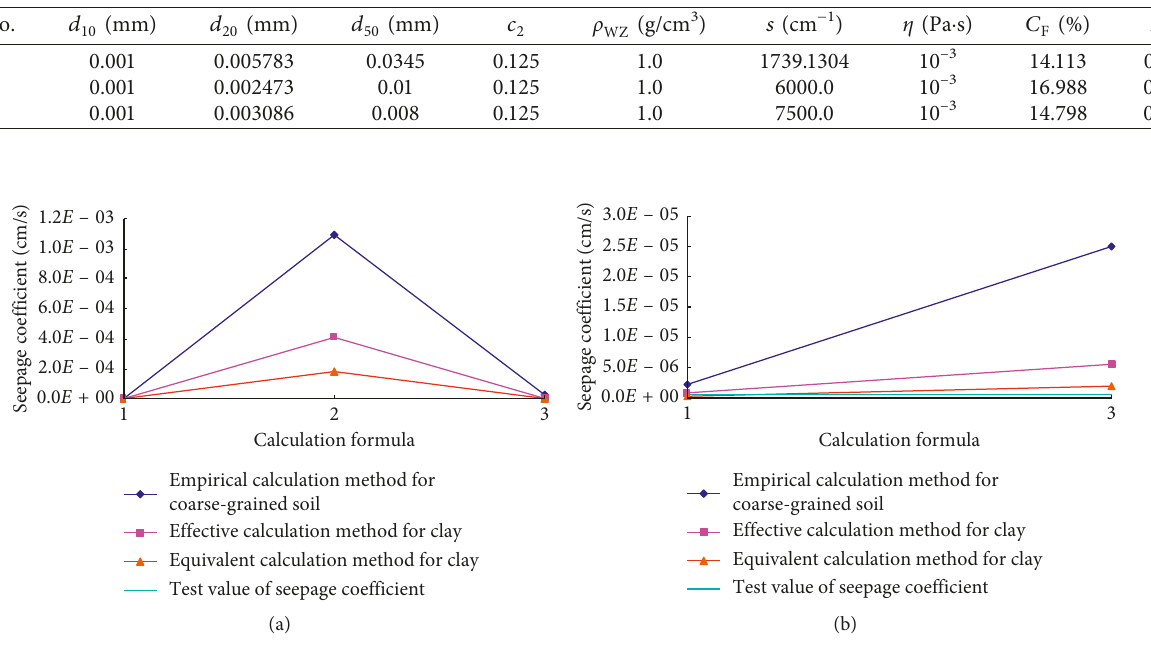
Table 7: The correlative calculation parameters.